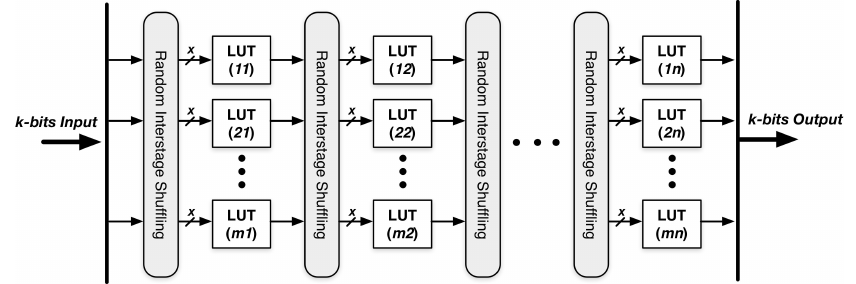
Figure 4. Non-deterministic random number generator (NDRNG).